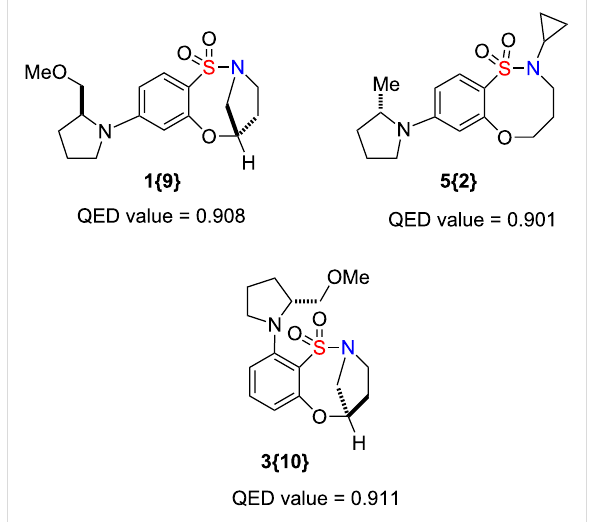
Figure 6: Three representative compounds with high QED values.